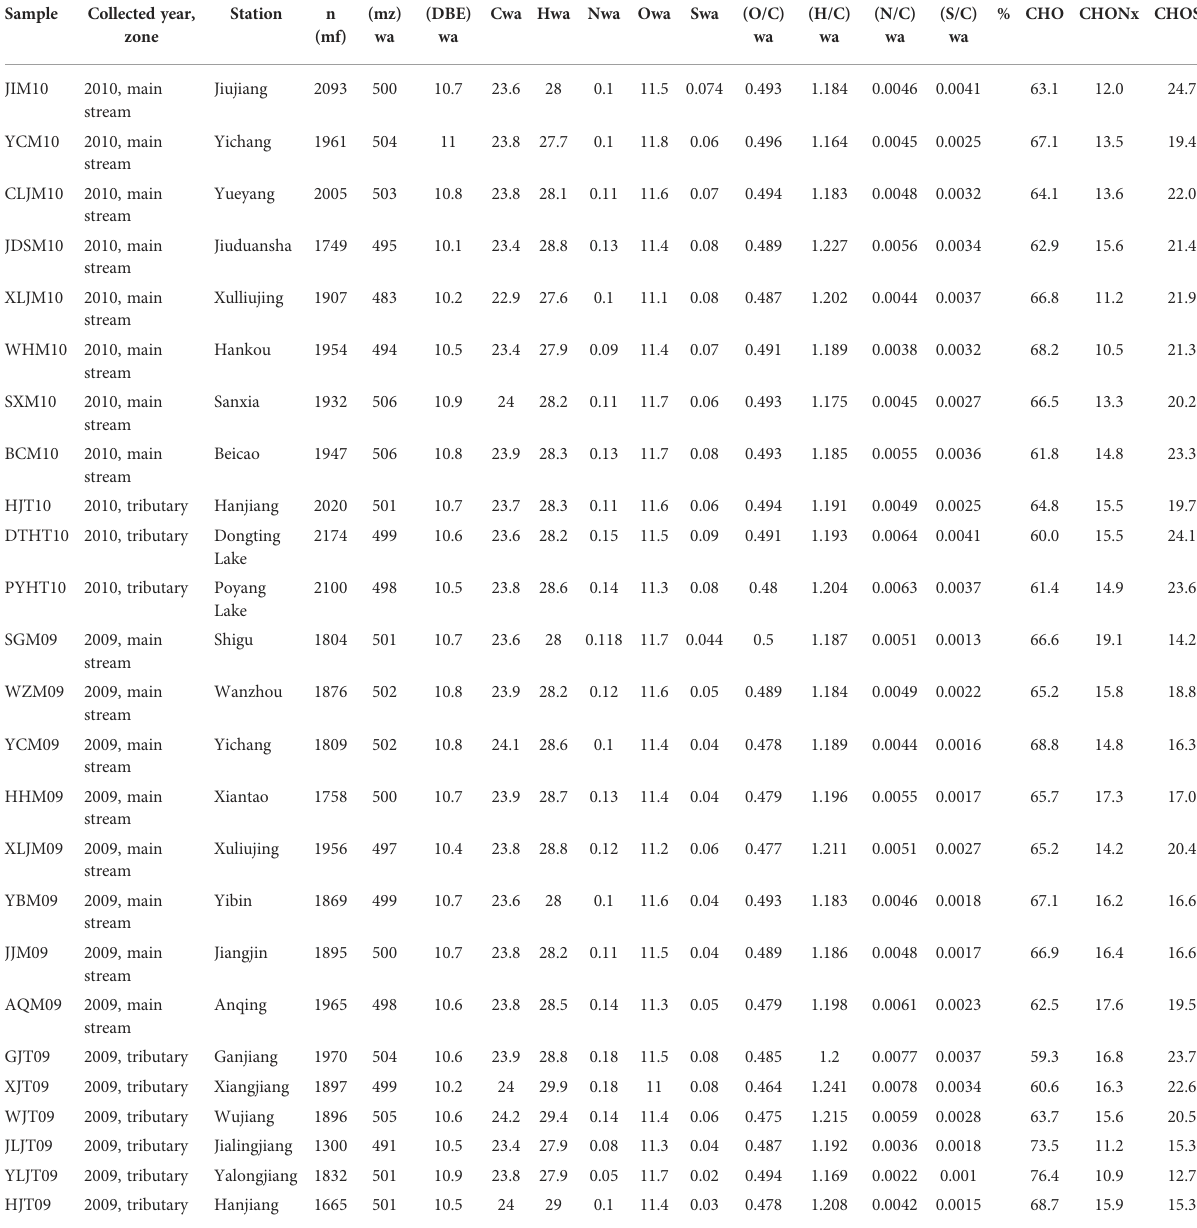
TABLE 1 Elemental parameters of dissolved organic matter collected from the Changjiang, intensity weighted average values for the formula compositions and number percentage of various groups (CHO, CHONx and CHOSx) are displayed for the comparison, X de fi nes as ≥ 1.